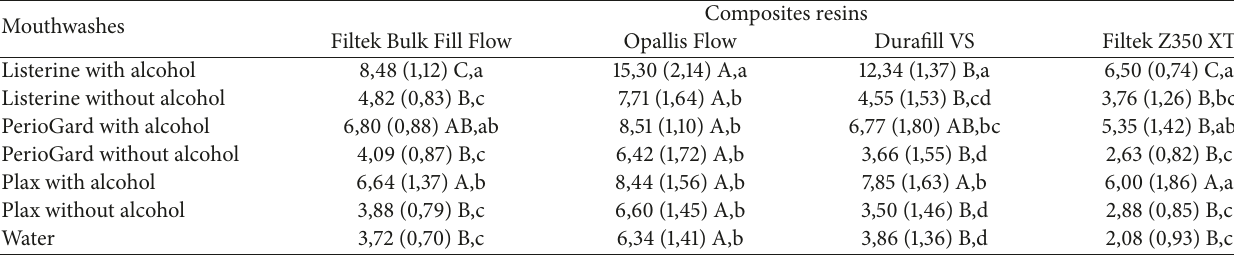
Table 4: Average ( ± SD) of solubility ( 𝜇 g/mm 3 ) according to composite resin and mouthwashes ( 𝑛 = 6 ). Mouthwashes